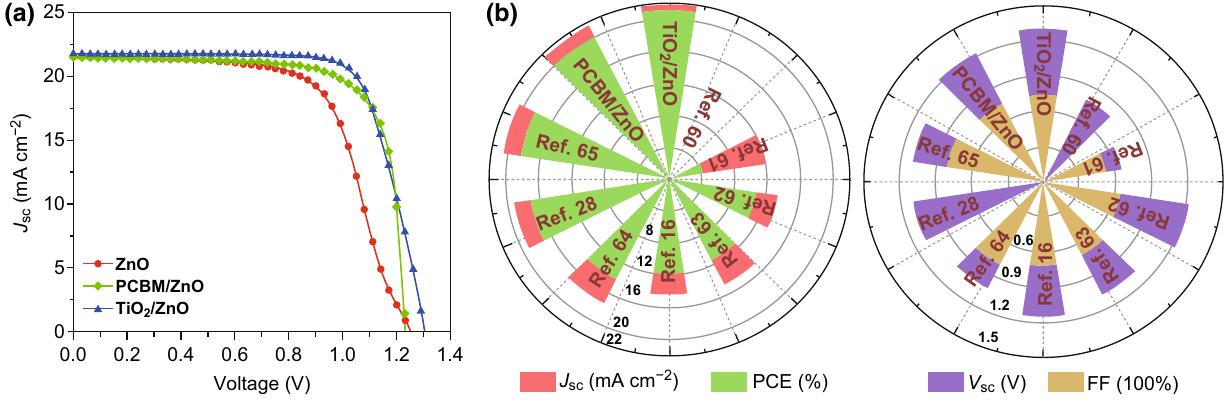
Fig. 8 a J – V characteristics of PSCs with a ZnO single-layer ETL, PCBM/ZnO bilayer ETL, and TiO 2 /ZnO bilayer ETL at a doping concentra- tion for the ZnO layer of 10 22 cm −3 . b Device parameters of PSCs with PCBM/ZnO bilayer ETLs and TiO 2 /ZnO bilayer ETLs optimized by a doping concentration of approximately 10 22 cm −3 in the ZnO layer coupled with the reported device performances of the CsPbI 3 -based